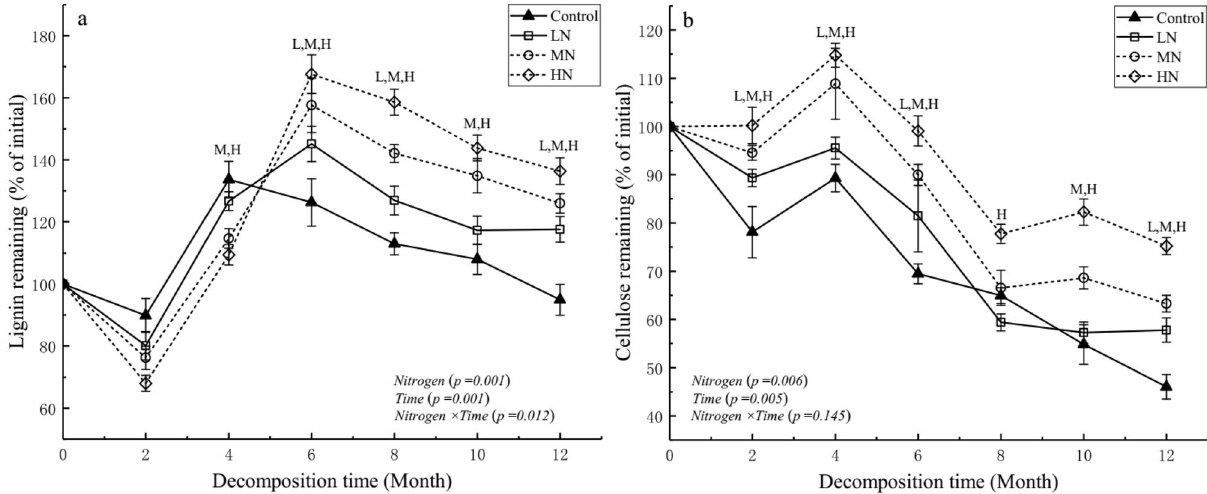
Figure 2. Effects of simulated N deposition on the dynamics of lignin and cellulose remaining in decomposing leaf litter. Values are expressed as mean ± standard error (SE) (n = 3). LN, MN, and HN at each decomposition time indicated that the difference between N treatments and control treatment is significant ( P <